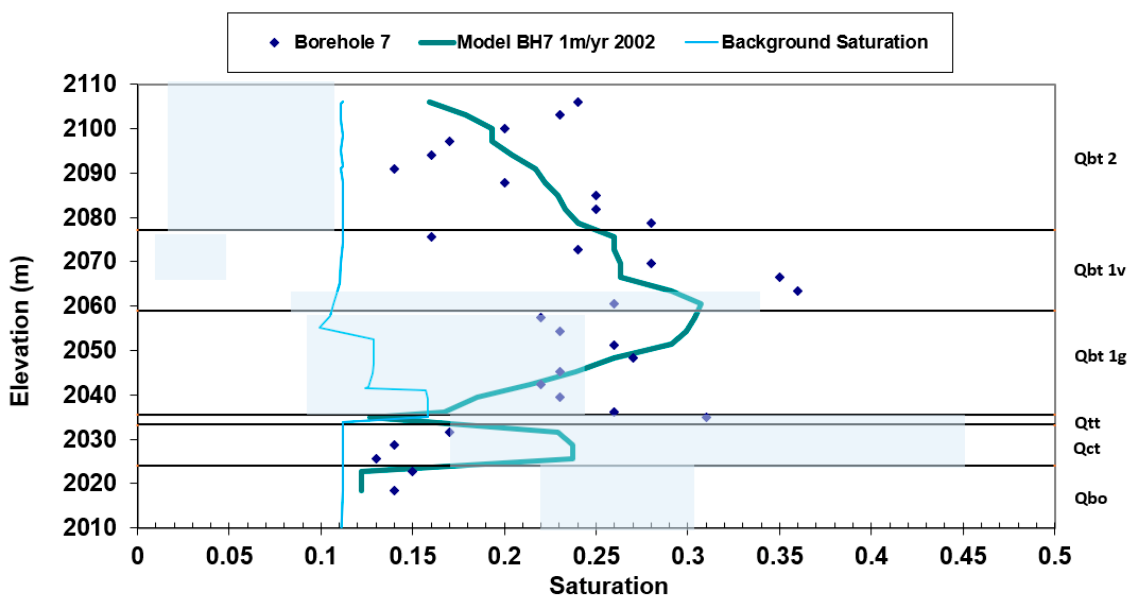
Figure 9. Simulations of saturation compared to site data for Borehole 7. The transparent blue shaded areas are 1 sigma saturation ranges from data presented by Birdsell et al. (2000) representing saturation ranges for a nearby mesa unimpacted by surface discharges.